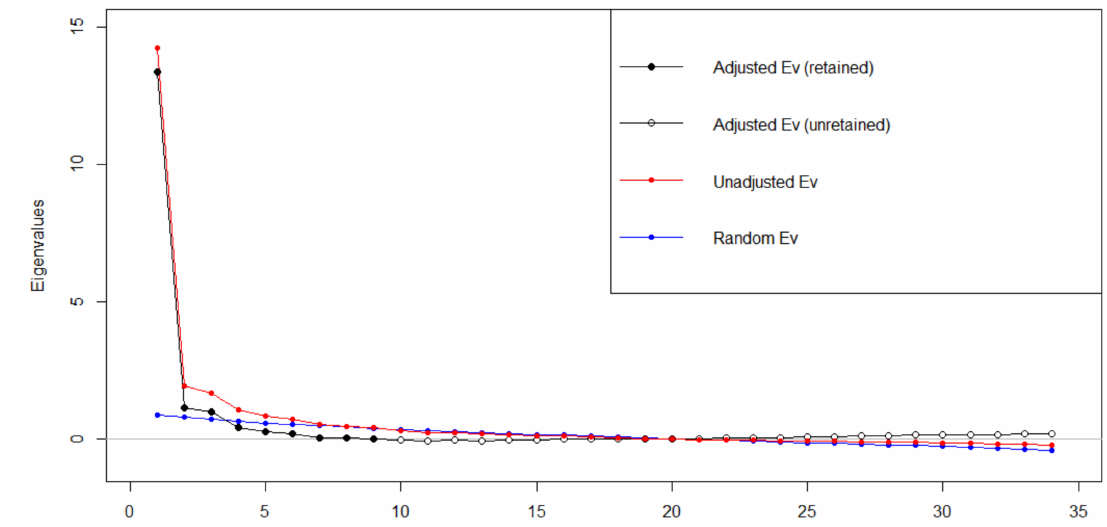
Figure 1. Scree plot for